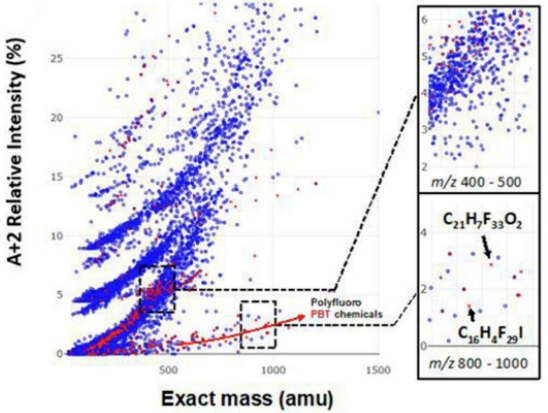
Figure 6. Distribution of 610 prioritized persistent bioaccumulative compounds (in red) and com- mercial chemicals (in blue) from the North American chemical inventories in the compositional spaces defined by m/z of the molecular ion and the ratio of its isotopic peaks (A + 2): A, where “A” is the most intense isotopic peak. Adapted from Zhang et al. [41]. Copyright 2019, with permission from Elsevier.